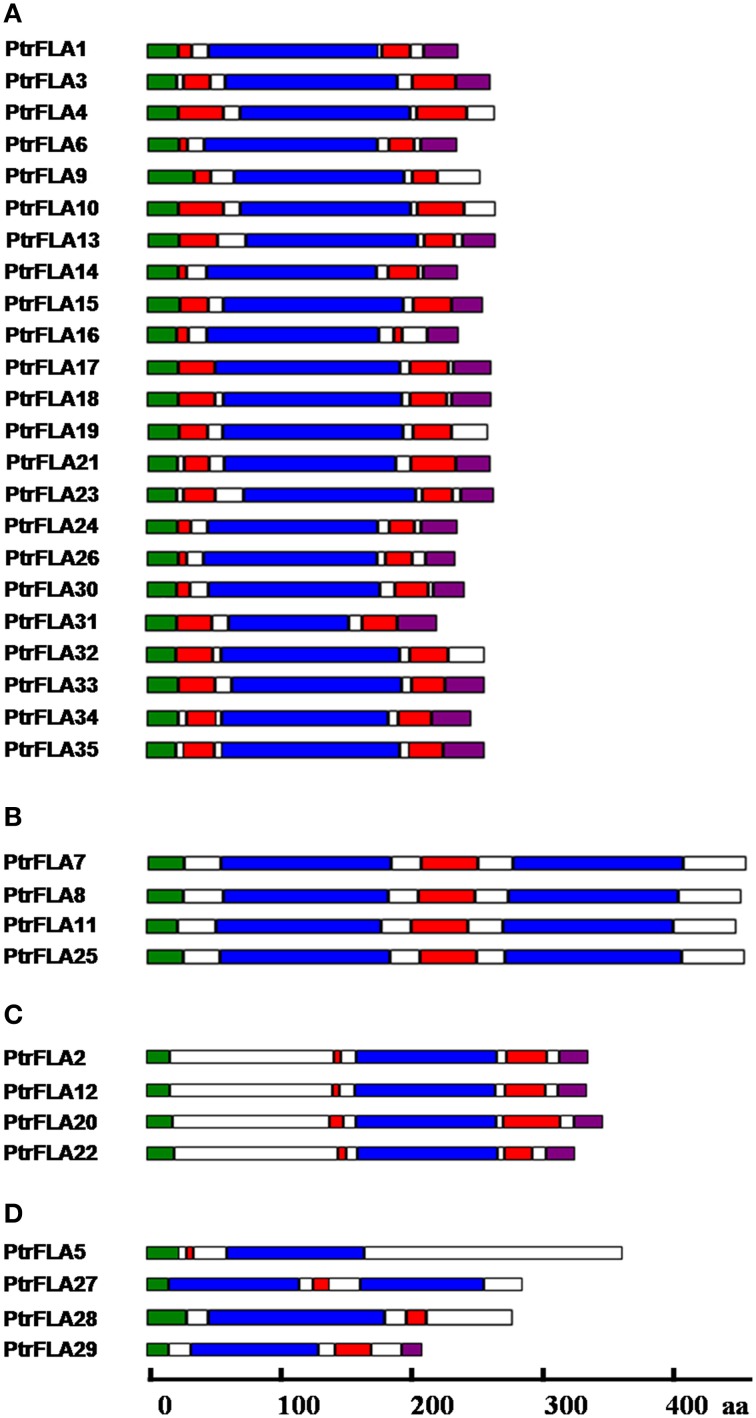
Schematic representation of PtrFLAs based on the numbers of AGP-like glycosylated regions and fasciclin domains. (A–D) Represent four different groups of PtrFLAs. The colored boxes indicate the N-terminal peptide signal (green), fasciclin domain (blue), AGP glycosylated region (red), and C-GPI anchor signal (purple), respectively.